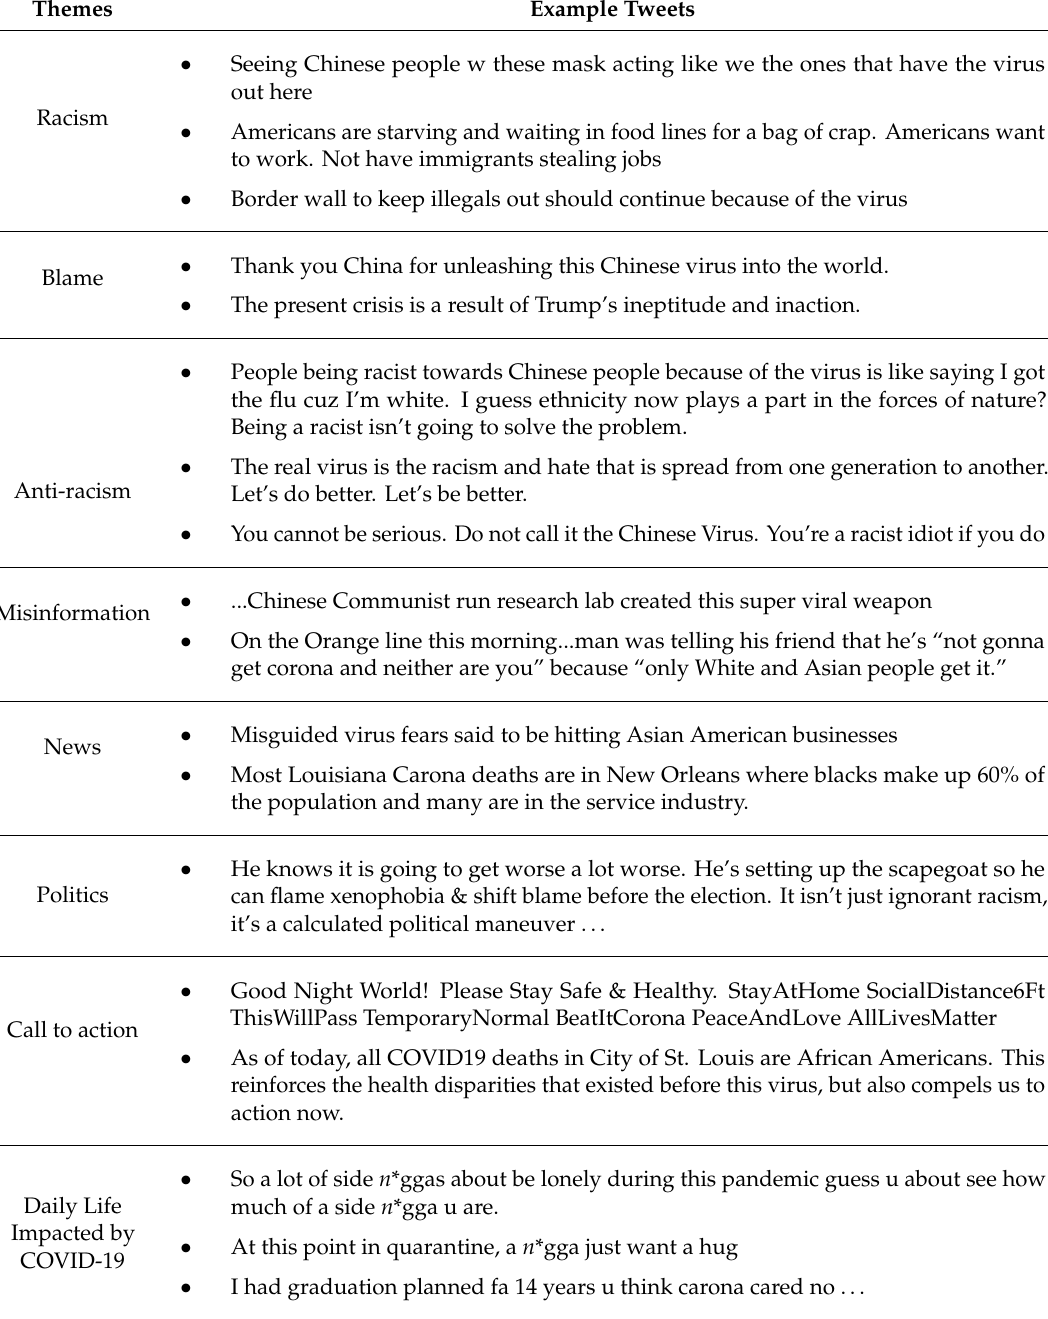
Table 4. Content analysis of themes with illustrative